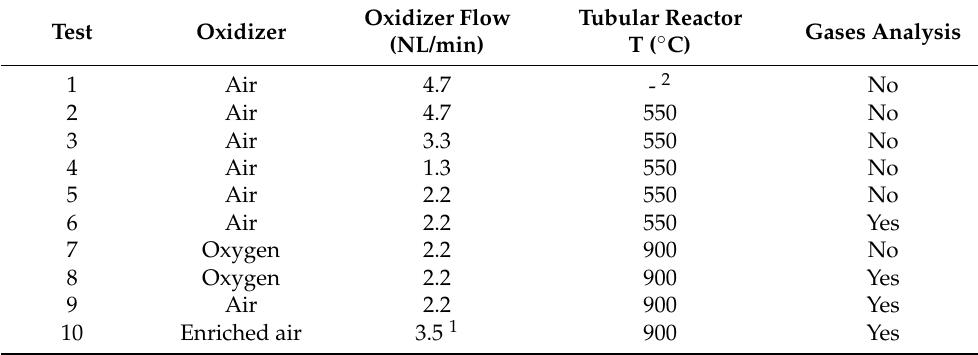
Table 1. Combustion tests performed. Reaction conditions with indication if the online gas analysis was